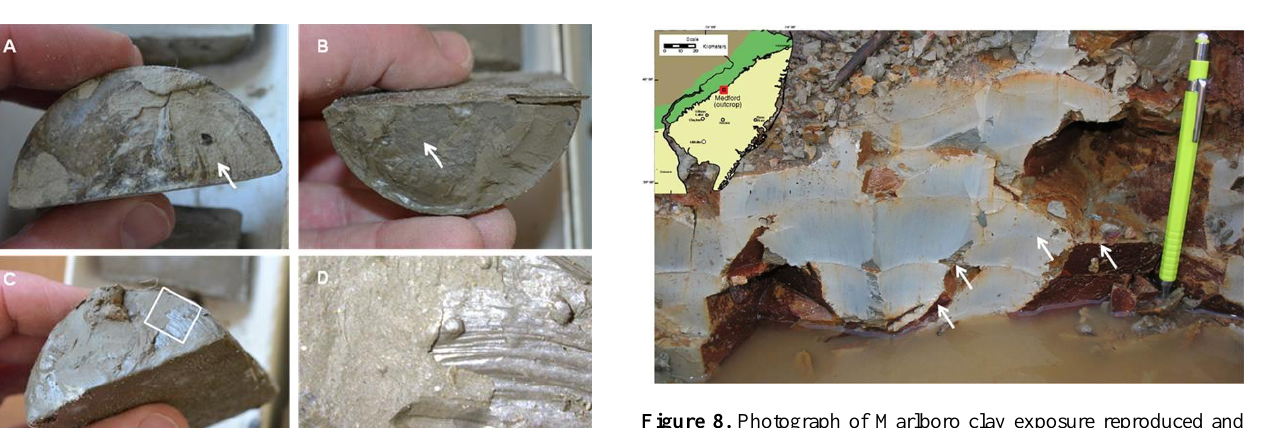
Figure 8. Photograph of Marlboro clay exposure reproduced and modified (arrows added) from Wright and Schaller (2014): “Photo- graph of the rhythmic bedding in the Marlboro clay exposed in the Rancocas Creek, Medford, NJ. Pencil is ∼ 15cm. ... The blue/gray clay is interrupted at regular ( ∼ 2cm intervals) by very thinly bed- ded silts and very fine sands. These areas also provide zones of weakness along which fractures will form when hand samples from the exposures are dried in the laboratory” (caption from Wright and Schaller, 2014). In our interpretation, the photograph shows several examples where joint surfaces curve and intersect one another in a fish-scale type arrangement. This is seen, for example, in the sur- face that forms a ledge behind the pencil (highlighted with arrows). No clear sedimentary bedding is